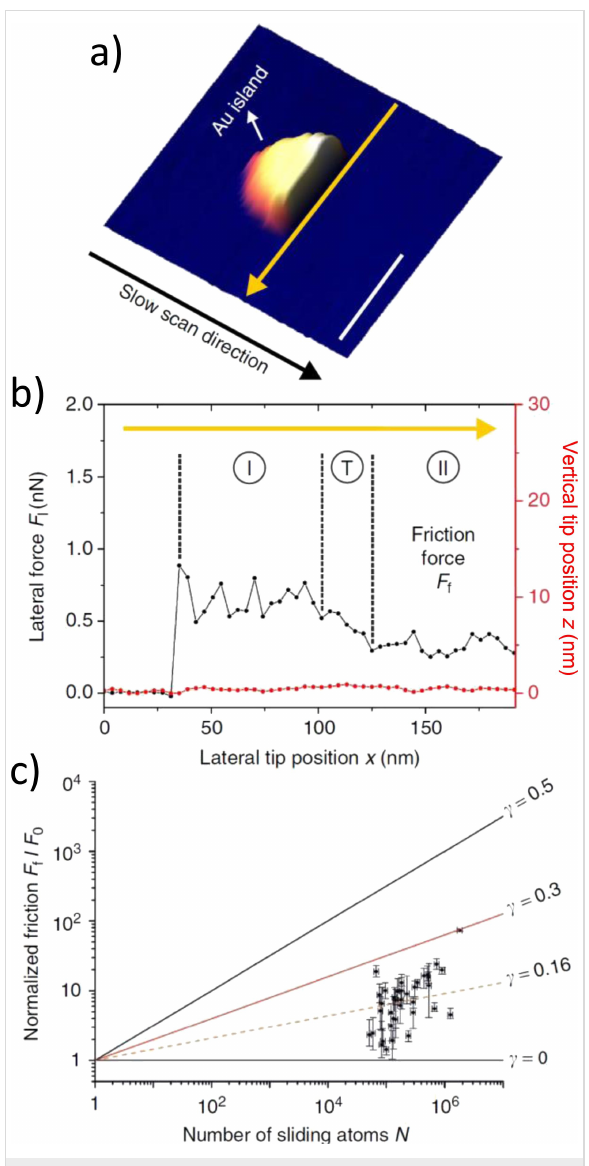
Figure 2: a) Example of a nanomanipulation during which half of a nanoparticle is scan-imaged, before the tip pushes it out of the image frame along the fast scan axis (yellow arrow). b) Friction trace ob- served during the manipulation. The AFM tip makes contact with the particle at x ≈ 30 nm. The stable lateral force level observed in region II has then been used as a measure for the interfacial friction between particle and substrate. c) Dependence of friction on the contact area obtained for an ensemble of Au nanoparticles. The absolute values fall well into the range anticipated by application of scaling laws for the specific material combination. Reprinted with permission from [47], copyright 2016 Springer